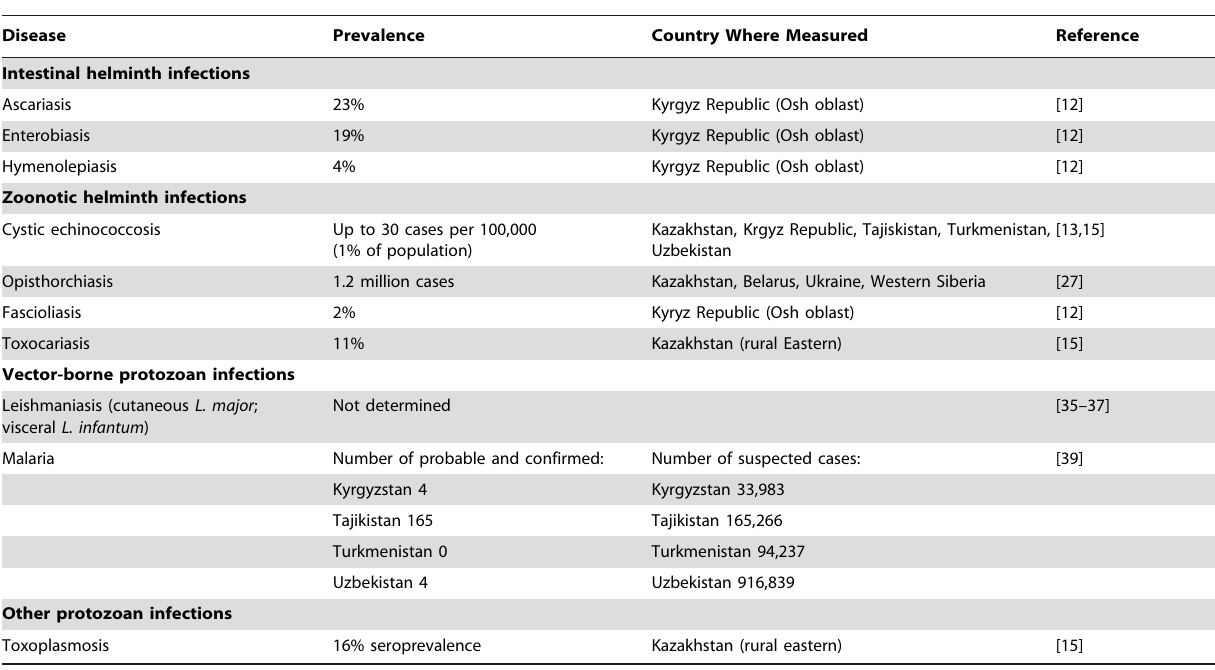
Table 1. Selected Neglected Tropical Diseases in Central